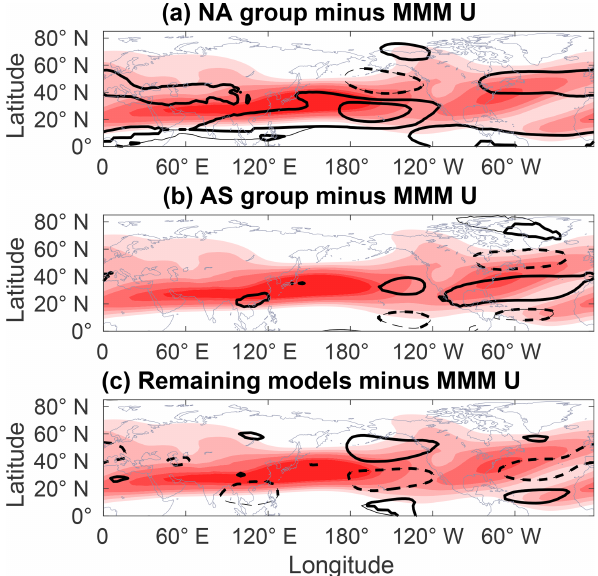
Figure 11. Jet stream spread in the ensemble. Data shown are monthly 300hPa DJF zonal wind group composites for the past period (1970–2005), with the MMM pattern removed. The con- tour interval is 1ms − 1 , with negative values denoted by dashed lines. Thick contours show areas where at least 90% of group mem- bers have the same sign as the group mean. Shading represents the MMM 300hPa climatological jet stream averaged over the same period ( U ≥ 10ms − 1 ; shading interval is 5ms − 1 ).